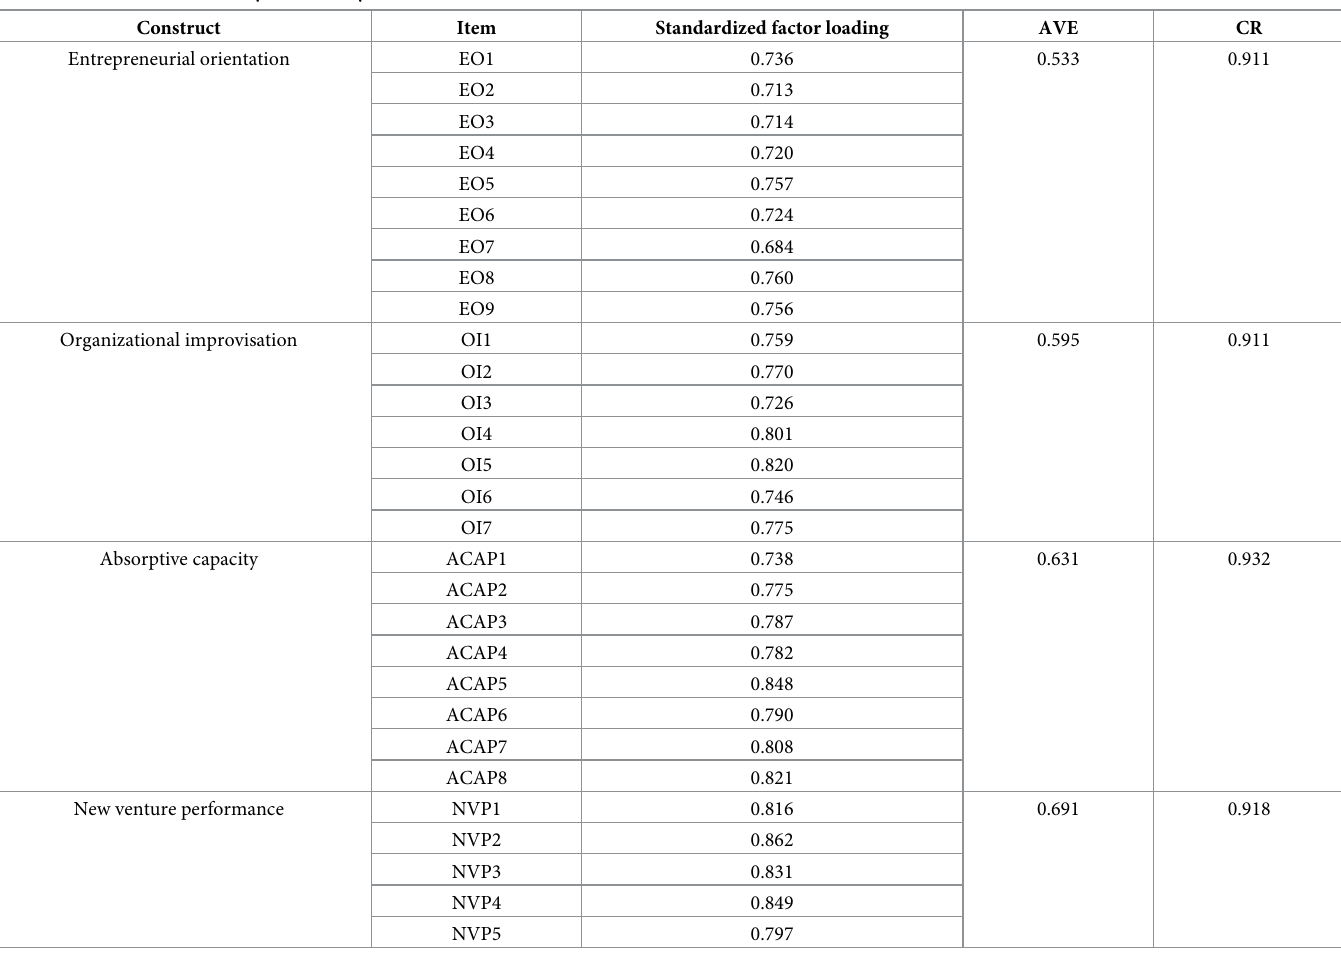
Table 3. Results of confirmatory factor analysis.